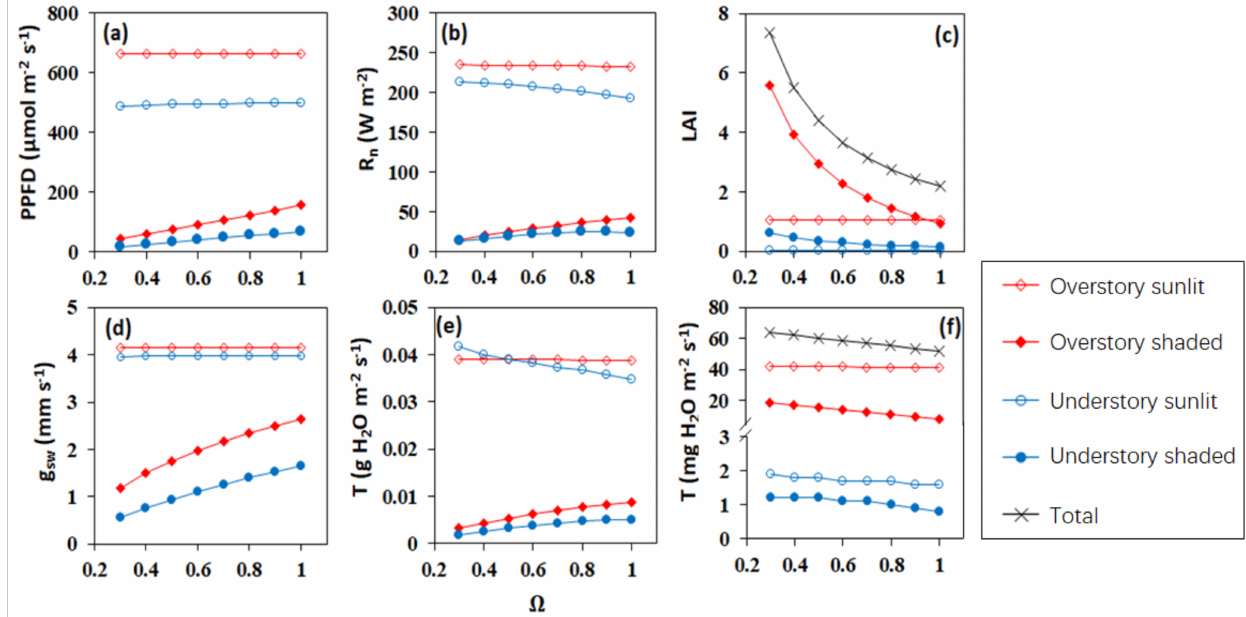
Figure 11. Variations of ( a ) PPFD, ( b ) R n , ( d ) g sw, and ( e ) T for a sunlit and a shaded leaf in the overstory and understory canopies; ( c ) LAI and ( f ) canopy-level T for overstory and understory canopies with Ω , when the effective LAI for the overstory and understory canopies are set as a constant of 2.0 and 0.2, respectively, which are common in a typical conifer forest (Case III). The values of the environmental variables are the same as those in Figure 8. The red open and filled diamonds represent the overstory sunlit and shaded components, respectively; the blue open and filled circles represent the understory sunlit and shaded components, respectively; the crosses represent the total of the four